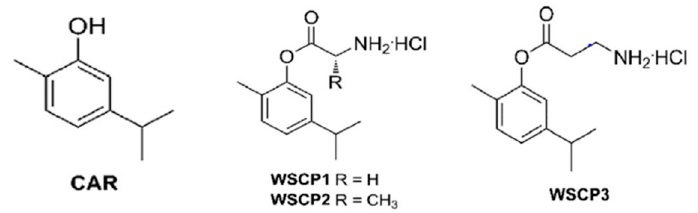
Figure 1. Chemical structures of CAR and its prodrugs.